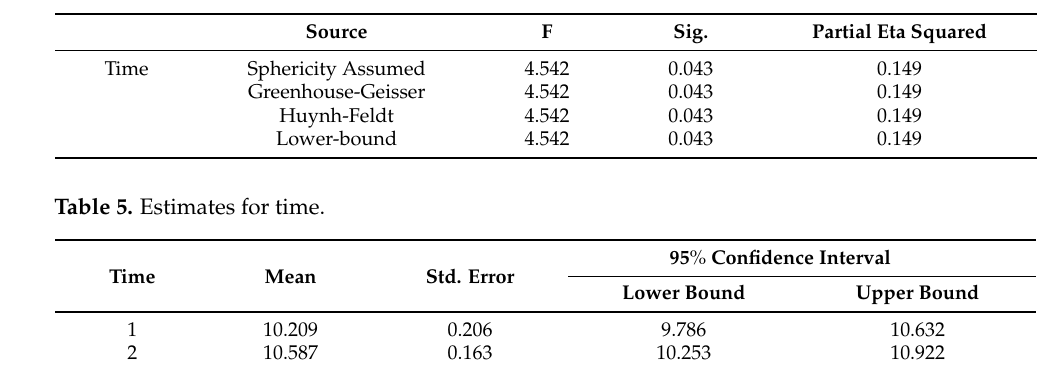
Table 4. Tests of Within-Subjects Effects for Alpha-Wave.